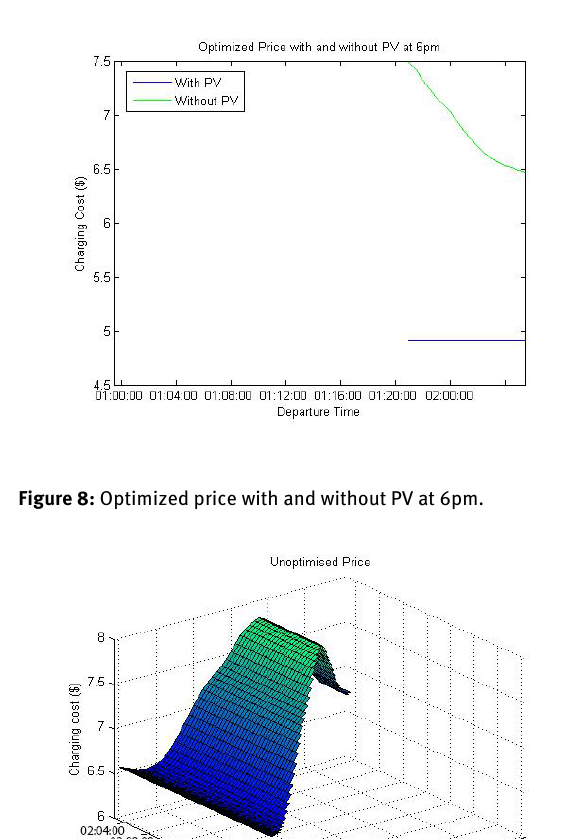
Figure 7: Optimized price with and without PV at 9am.